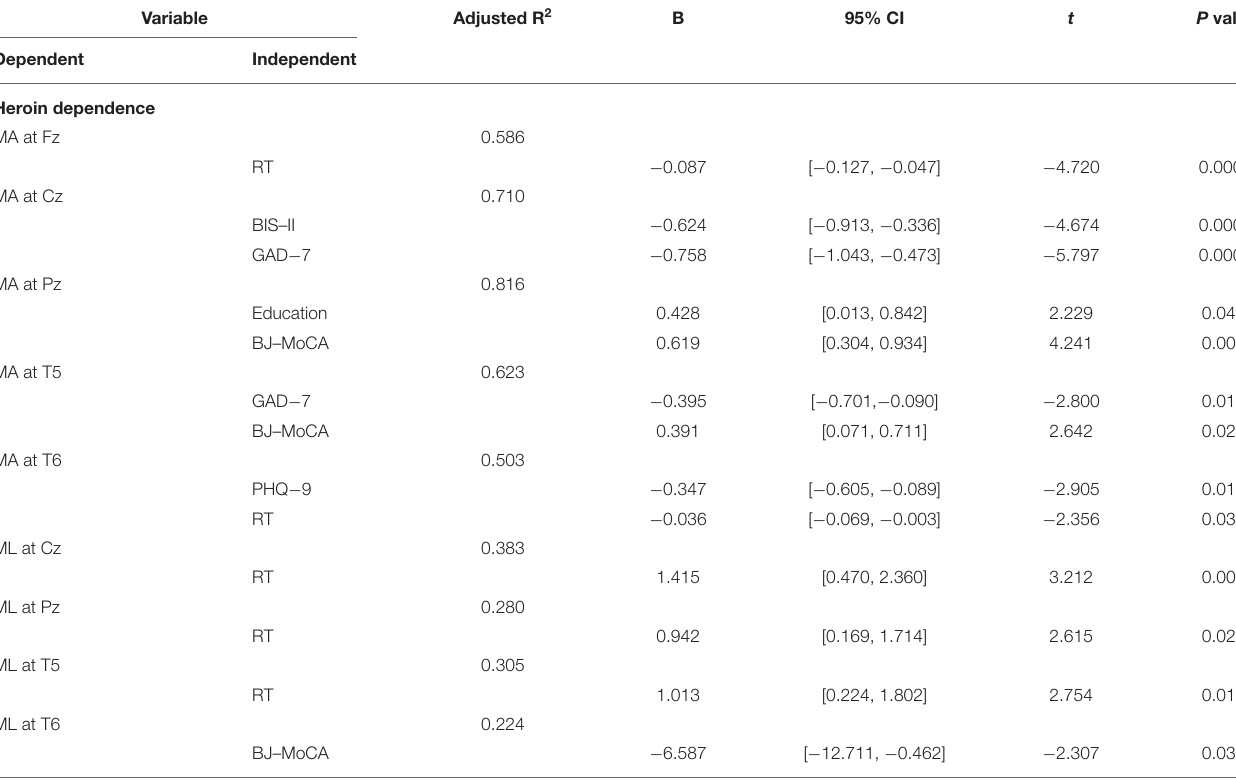
TABLE 3 | Stepwise regression model results for mean amplitude and mean latency of the heroin